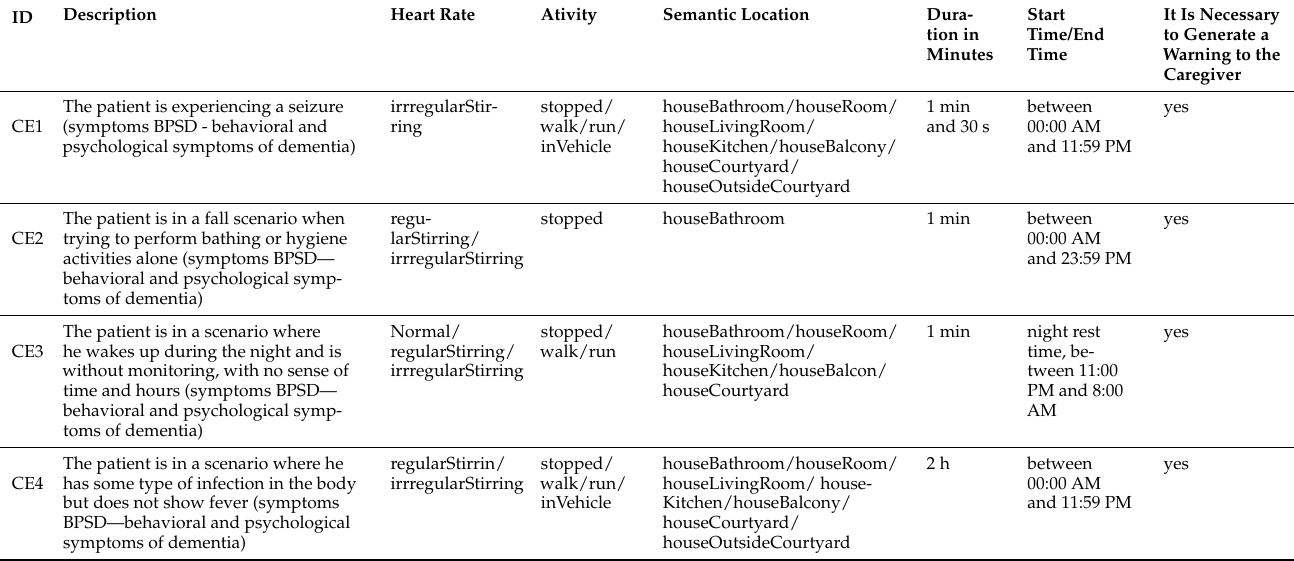
Table 3. Scenarios developed based on the